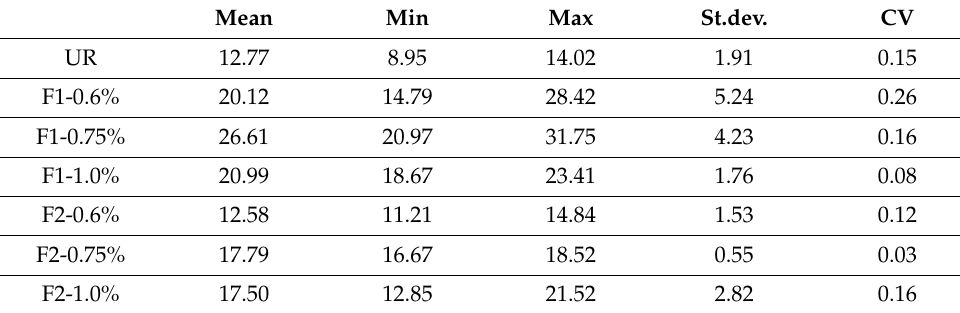
Table 9. Statistical data of the CTs. CV is the coefficient of variation.